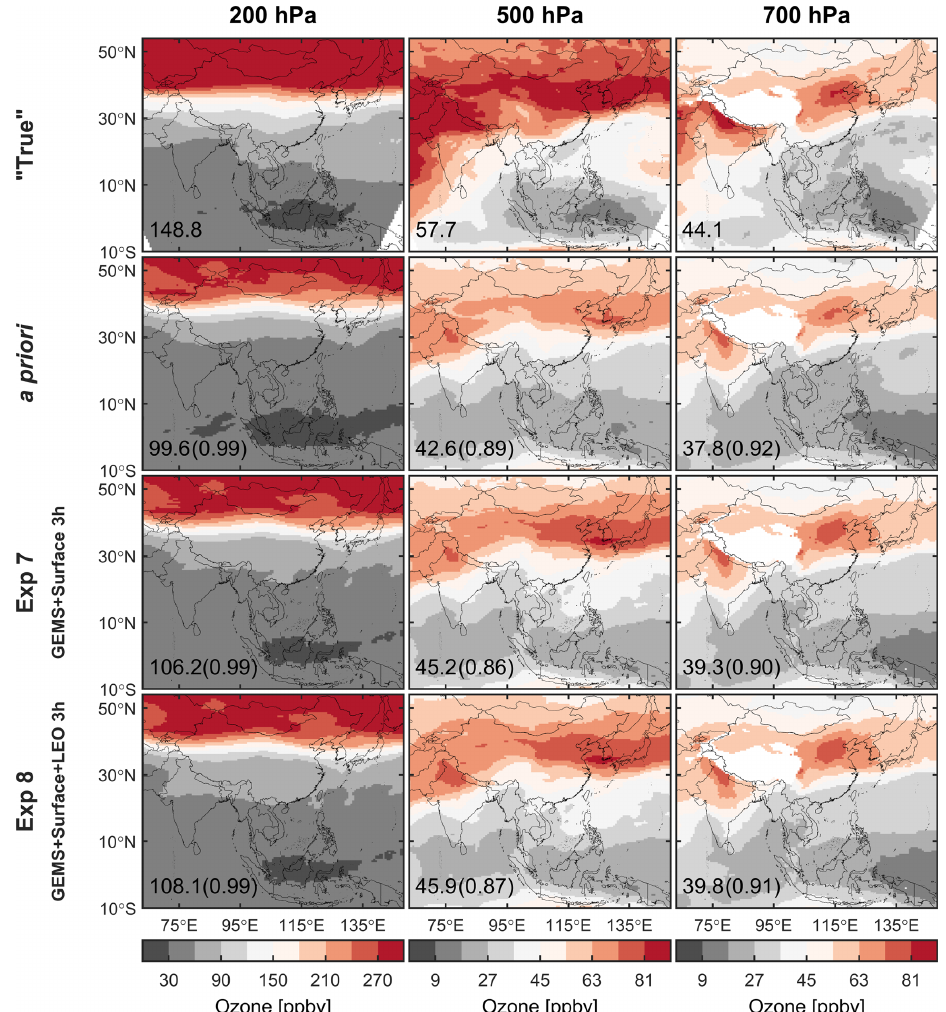
Figure 8. Monthly mean MDA8 ozone at 200 (left panels), 500 (middle panels), and 700hPa (right panels) for June 2020 over the Asian domain, as simulated by the nature run (“True”), the control run (a priori), and two assimilation runs (Exp 7 and 8 in Table 1). The domain- averaged value is inset. For the control run and assimilation runs, the spatial correlation coefficients relative to the nature run are also inset in